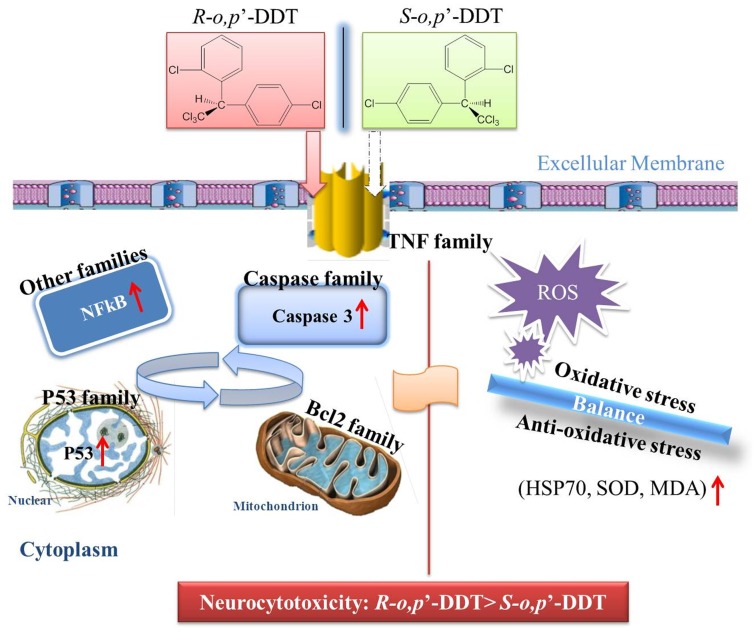
A speculated signaling pathway mediated by o,p’-DDT for the induction of cells apoptosis.The red arrowheads indicate the more significant upregulation of apoptosis-related molecules induced by R-form than that of S-form. Reactive oxygen species (ROS), Heat shock proteins (HSPs), Lactate dehydrogenase (LDH), Superoxide dismultase (SOD), Malondialdehyde (MDA).